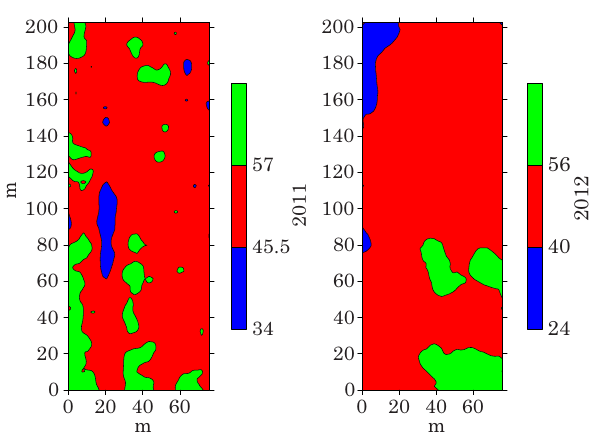
Figura 7. Zonas homogêneas do número de cachos de uva por videira em toda a área, nos ciclos de produção de 2011 e 2012.